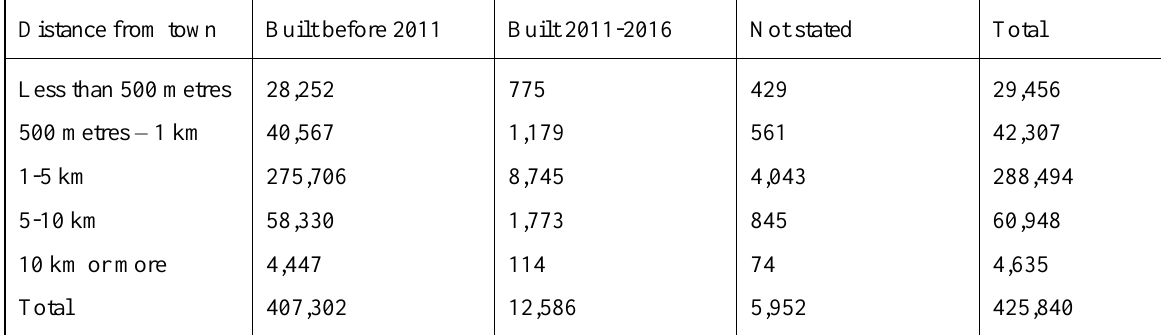
Table 1: Distance of one-off housing from town by year built, 2016 (,20) Distance from town Built before